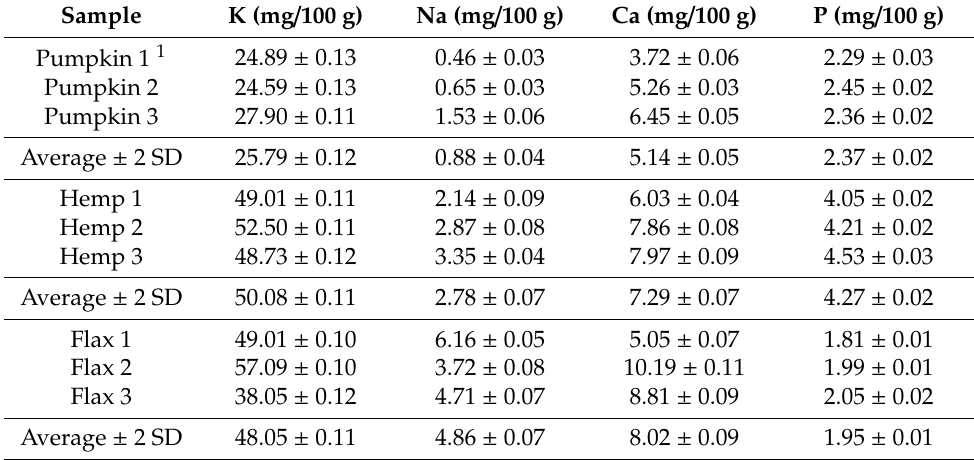
Table 2. Mineral content (mg / 100 g dry weight) in oilseed cake extracts obtained by subcritical water.